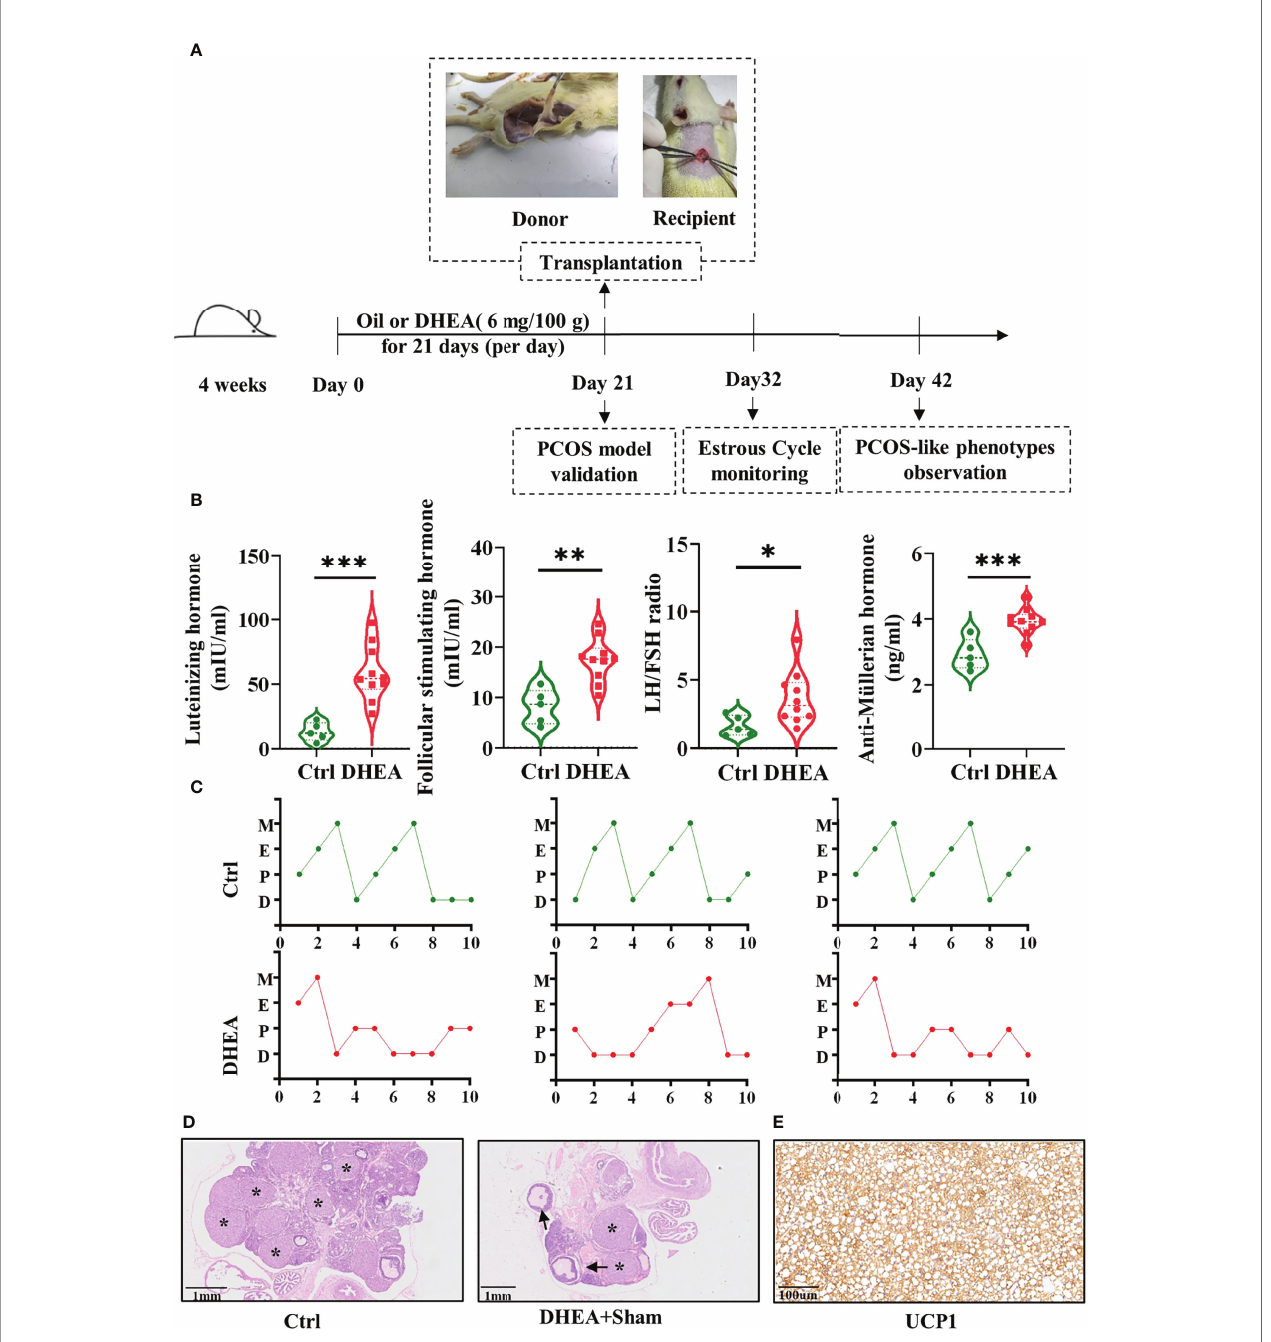
FIGURE 1 | BAT transplantation in a PCOS rat model. (A) Scheme of the group assignments and timeline of the experiment process ( n = 24). Female SD rats were treated with DHEA for 21 days to construct the PCOS model. BAT transplantation or sham operation was performed on day 21. Donor rats, within 14 days after birth, were operated on to take BAT and then BAT was transplanted to PCOS model rats. The estrous cycles were checked daily for the following 10 days. Reproductive and metabolism phenotype detection was done on day 42. (B) Serum concentrations of FSH, LH, and AMH, as well as the LH/FSH ratio (5 control rats and 10 DHEA rats). (C) . Disordered estrous cycles were observed in PCOS rats. (D) H&E staining of the ovarian tissues from the Ctrl and DHEA+Sham groups ( scale bar , 1 mm). Ovarian histology revealed that cystic follicles ( arrow ) and a few corpora lutea ( asterisk ) appeared in the DHEA group compared with the Ctrl group. (E) UCP1 was identi fi ed by immunohistochemistry in the donor BAT ( scale bar , 100 µm). PCOS , polycystic ovary syndrome; BAT , brown adipose tissue; SD , Sprague – Dawley; DHEA , dehydroepiandrosterone; FSH , follicle-stimulating hormone; H&E , hematoxylin and eosin; LH , luteinizing hormone; AMH , anti-Müllerian hormone; UCP1 , uncoupling protein 1; D, diestrus; E, estrus; M, metestrus; P, proestrus. Data were analyzed using unpaired Student ’ s t -test. * p < 0.05, ** p < 0.01, *** p <